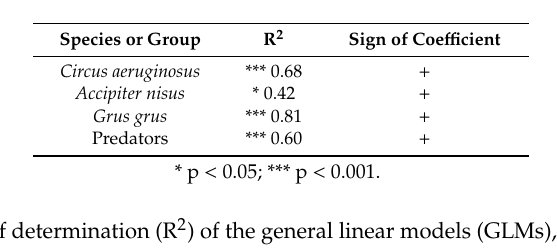
Table 5. Coe ffi cients of determination (R 2 ) of the general linear models (GLMs) using bird species and groups as dependent variable and mean annual discharge as independent variable. Taxa and groups with non-significant values are not shown.